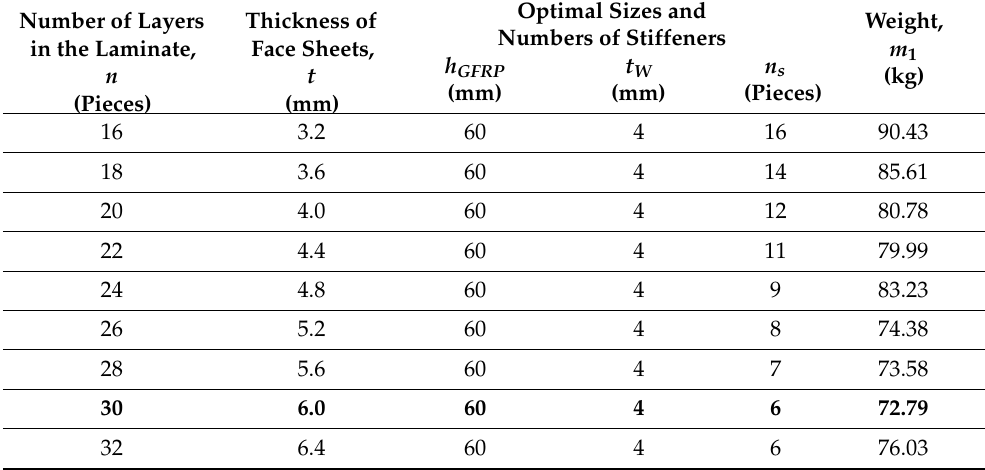
Table 4. Result of the weight optimization.